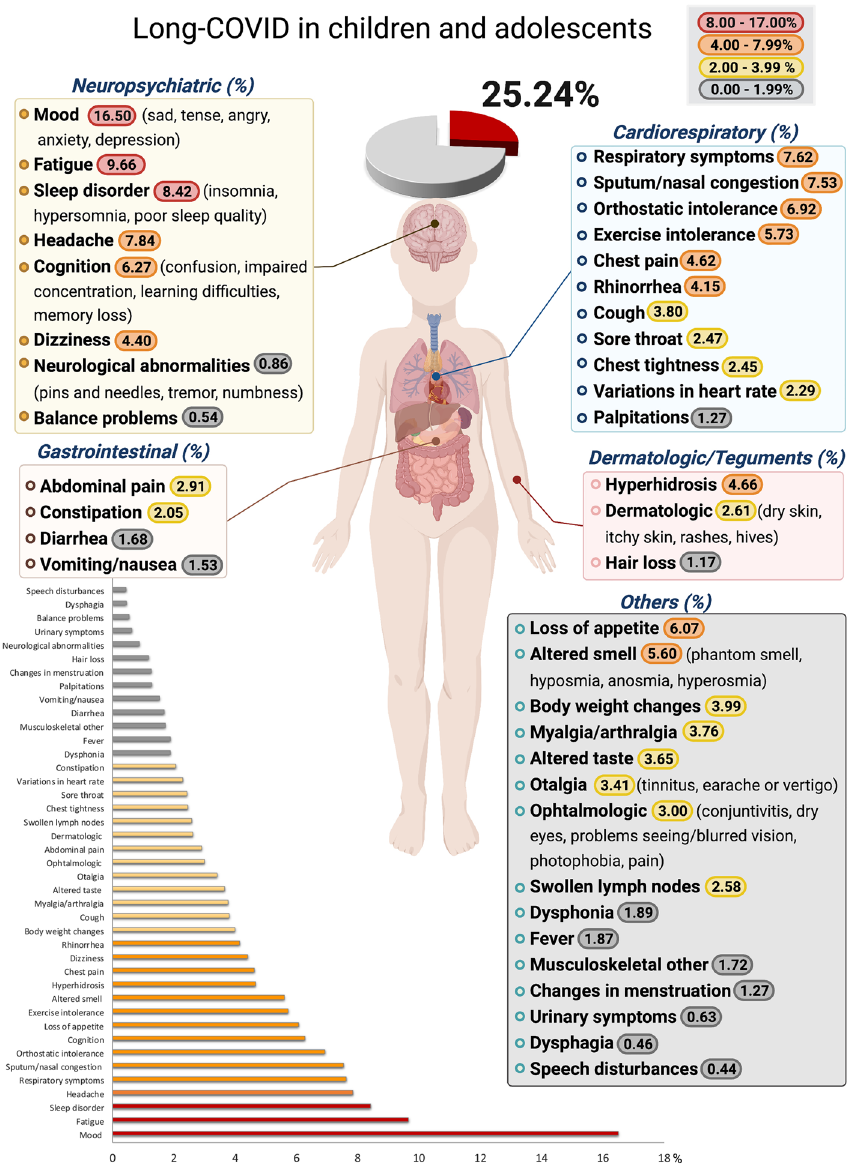
of one or more symptoms following a SARS-CoV-2 infection was